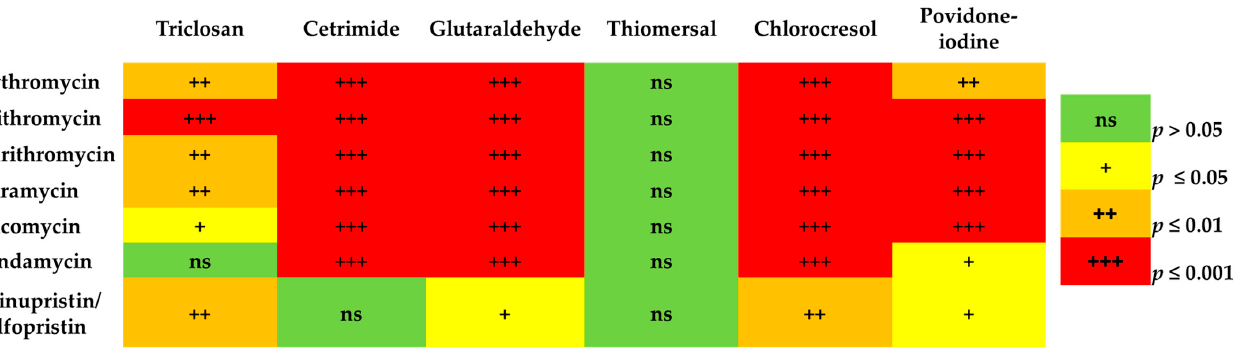
9 of 20 Figure 6. The percentages of reduced susceptible isolates to biocides (MIC ≥ MIC 50 ) in the antibiotics- resistant isolates with MIC ≥ MIC 50 . The chi-square test was used to compare the difference in the percentage of antibiotic-resistant isolates with MIC above or below the MIC 50 of tested biocides. It was observed that in the antibiotic-resistant isolates, the percentages of reduced susceptible isolates to all biocides except thiomersal were increased significantly. ns: p > 0.05, *: p ≤ 0.05, **: p ≤ 0.01, ***: p ≤ 0.001. In addition, Pearson’s correlation coefficients between MIC values for MLS antibiot- ics and biocides of individual isolates. There was a stronger correlation between increas- ing MIC values for antibiotics and biocides ( p < 0.05 was considered significant) (Figure